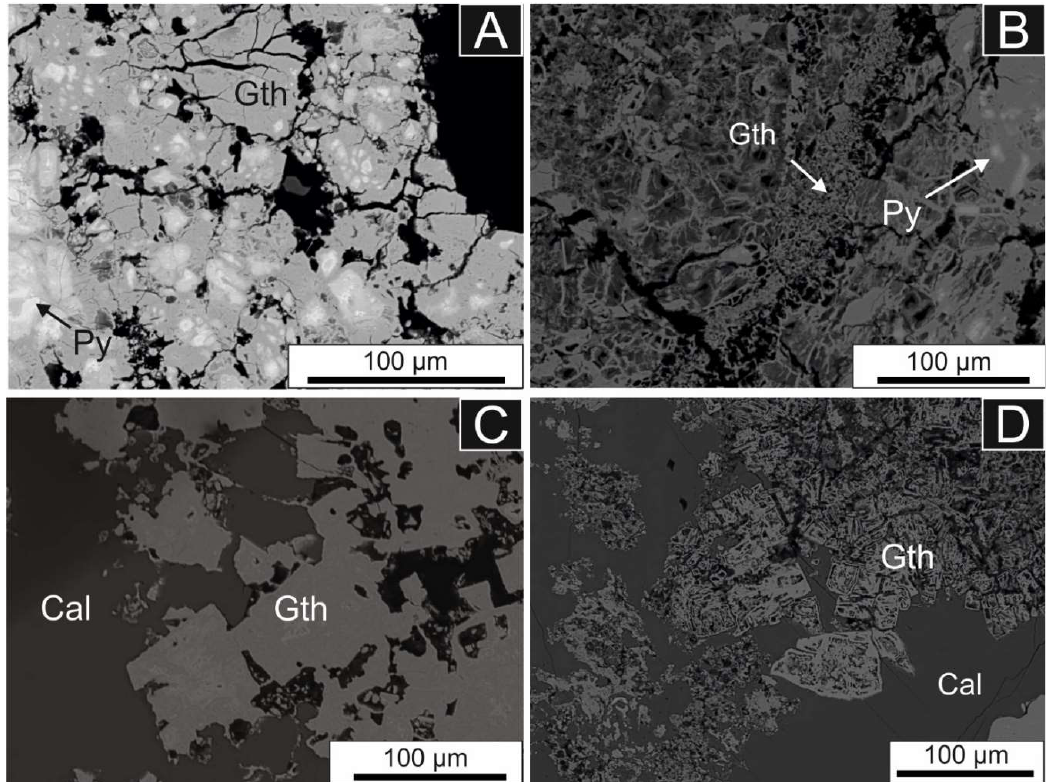
Figure 2. Backscattered Electrons (BSE) images of Fe-oxy-hydroxides occurring in the Jabali and Hakkari deposits: ( A ) and ( B ) cryptocrystalline goethite replacing pyrite (Hakkari), ( C ) goethite pseudomorph after pyrite (Jabali), ( D ) skeletal goethite after pyrite (Jabali). Abbreviations: Gth = goethite, Py = pyrite, Cal = calcite. Abbreviations are from Reference